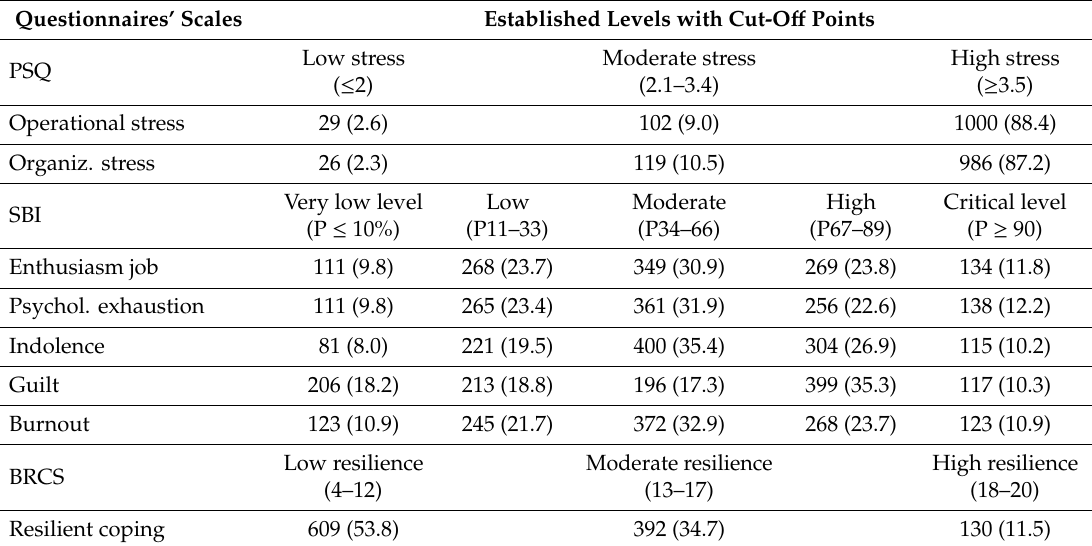
Table 3. Sample’s frequency (and percentage) distribution according established cut-o ff